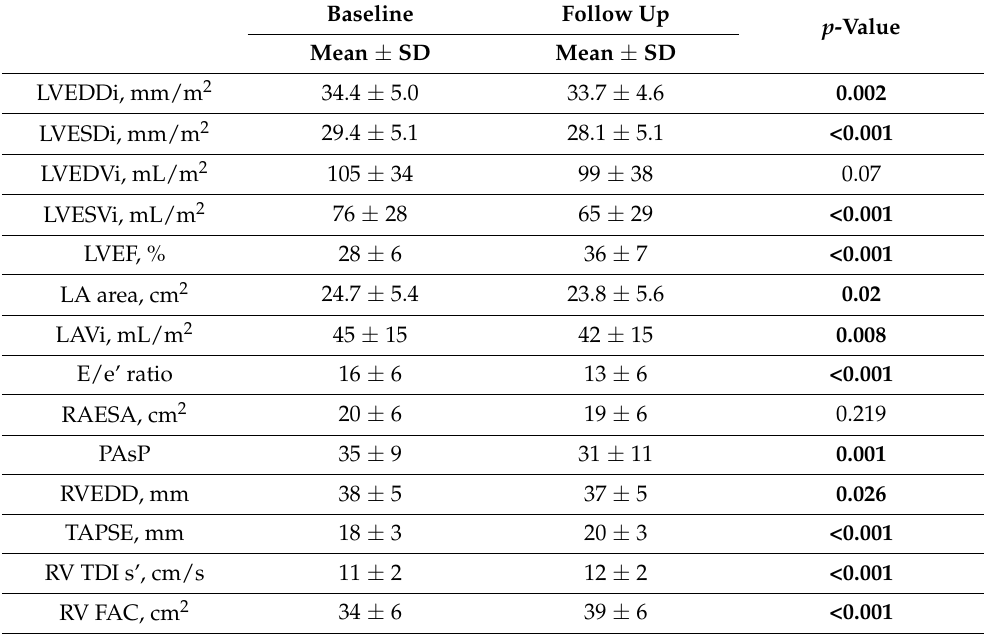
Table 2. Standard echocardiographic